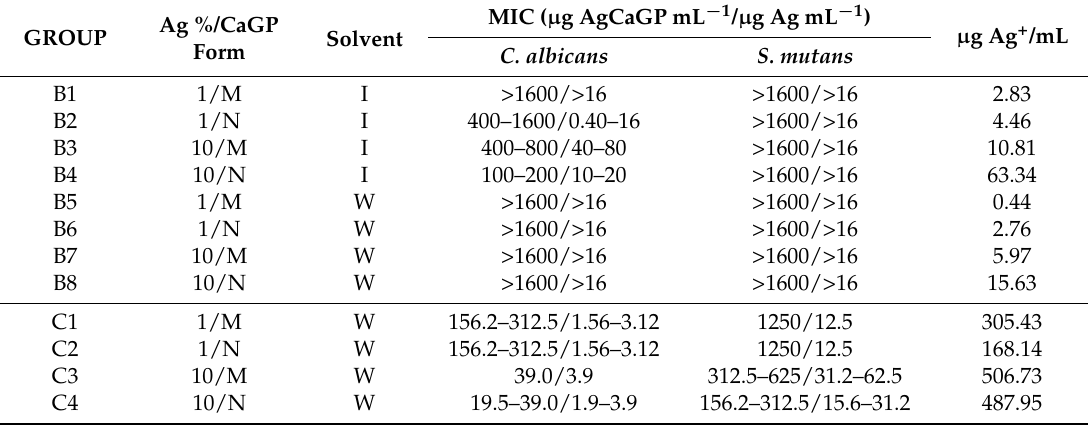
Table 1. Values of minimum inhibitory concentration (MIC) of the nanocompounds based on µ g of